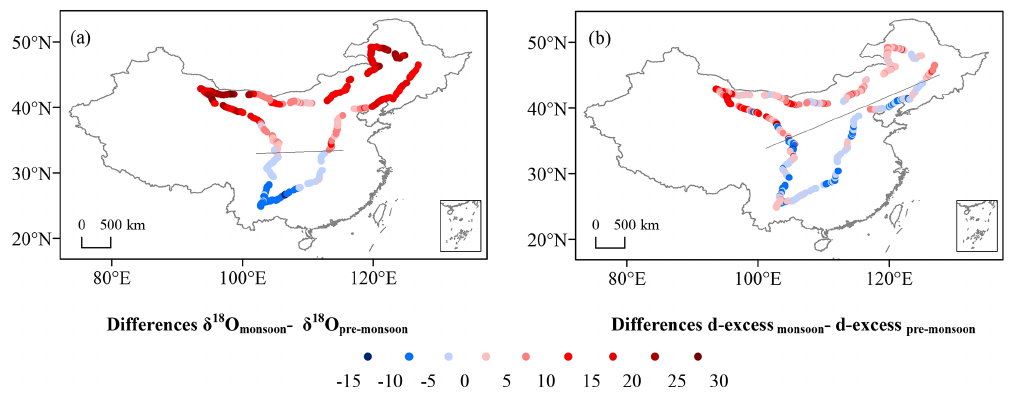
Figure 7. Spatial distribution of the isotope differences ( δ 18 O monsoon − δ 18 O pre-monsoon (a) and d-excess monsoon − d-excess pre-monsoon (b) ) for the observation locations. The solid black lines separate the areas of positive and negative values of the differences.